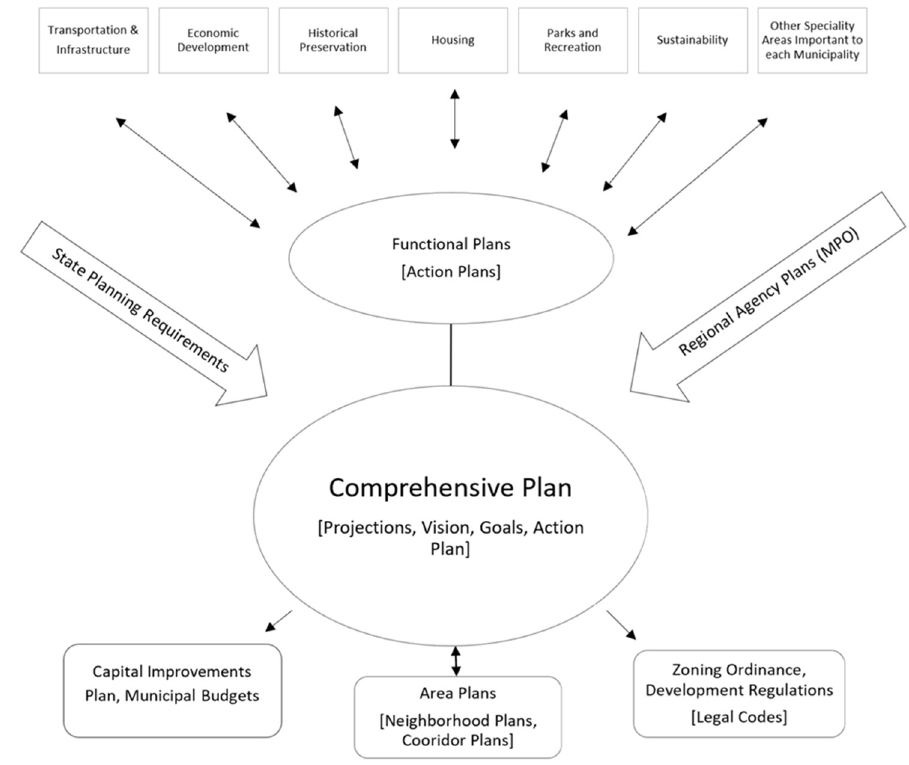
Figure 2. The constellation of plans: comprehensive plan model.